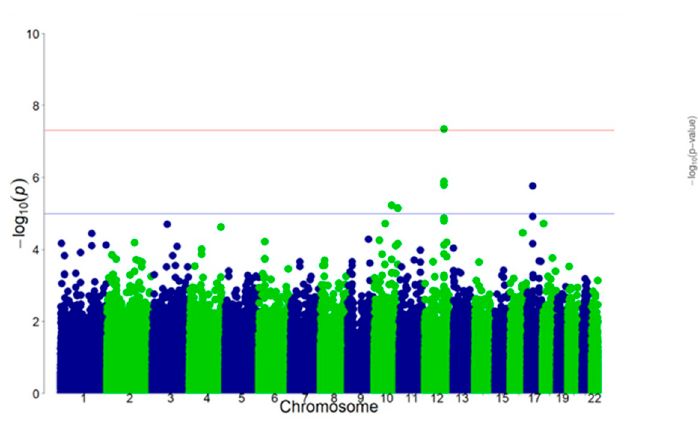
Figure 2. ( A ) Manhattan plot analysis. The x -axis represents chromosomal positions and the y -axis represents − log 10 p values. The red and blue horizontal lines indicate the genome-wide significance ( p = 5.0 × 10 − 8 ) and suggestive significance ( p = 5.0 × 10 − 5 ) levels, respectively. ( B ) Area plot of chro- mosome 12, showing the relative location of rs4445711.